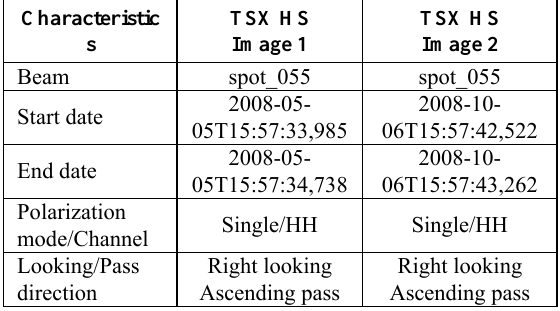
Table 2. Characteristics of high resolution TSX SL Istanbul SAR image-pair.